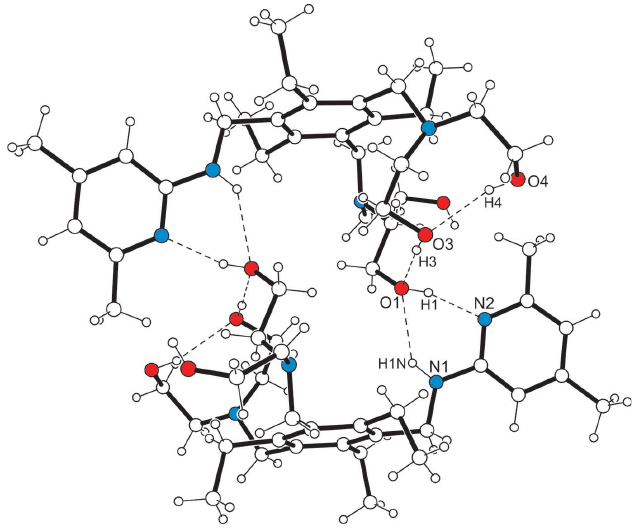
Figure 2 Structure of the molecular dimer including the numbering of atoms involved in hydrogen-bonding interactions. For the sake of clarity, only the major position of the disordered hydroxyethyl moiety is shown. Hydrogen bonds are shown as dashed lines.